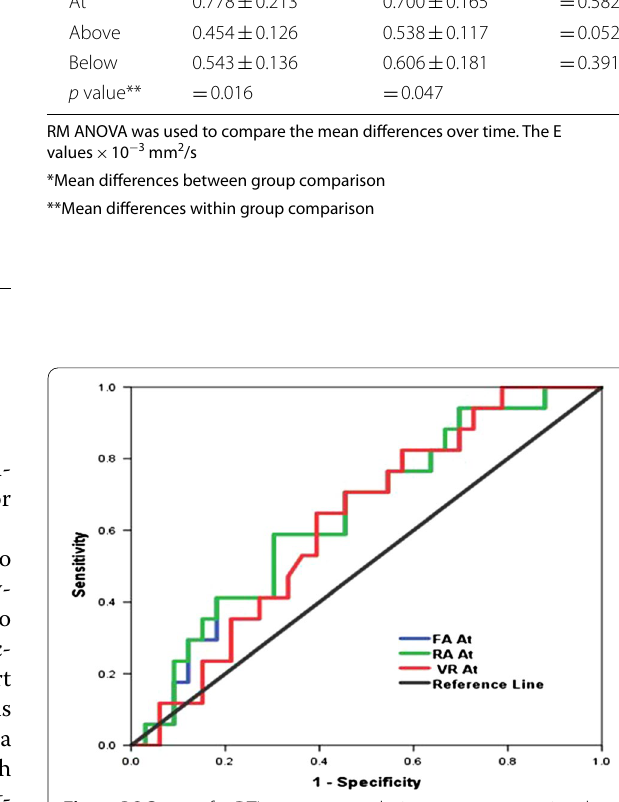
Fig. 4 ROC curve for DTI parameters at lesion versus